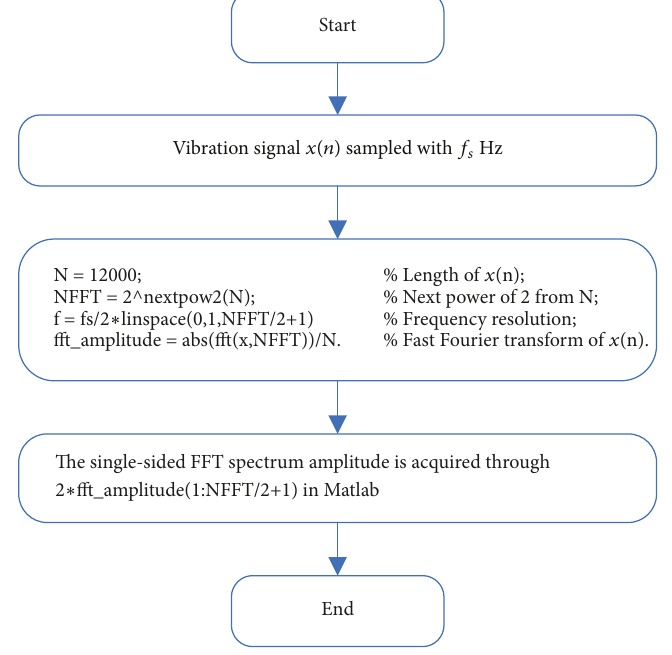
Figure 2: Flowchart of FFT spectrum amplitudes creation in